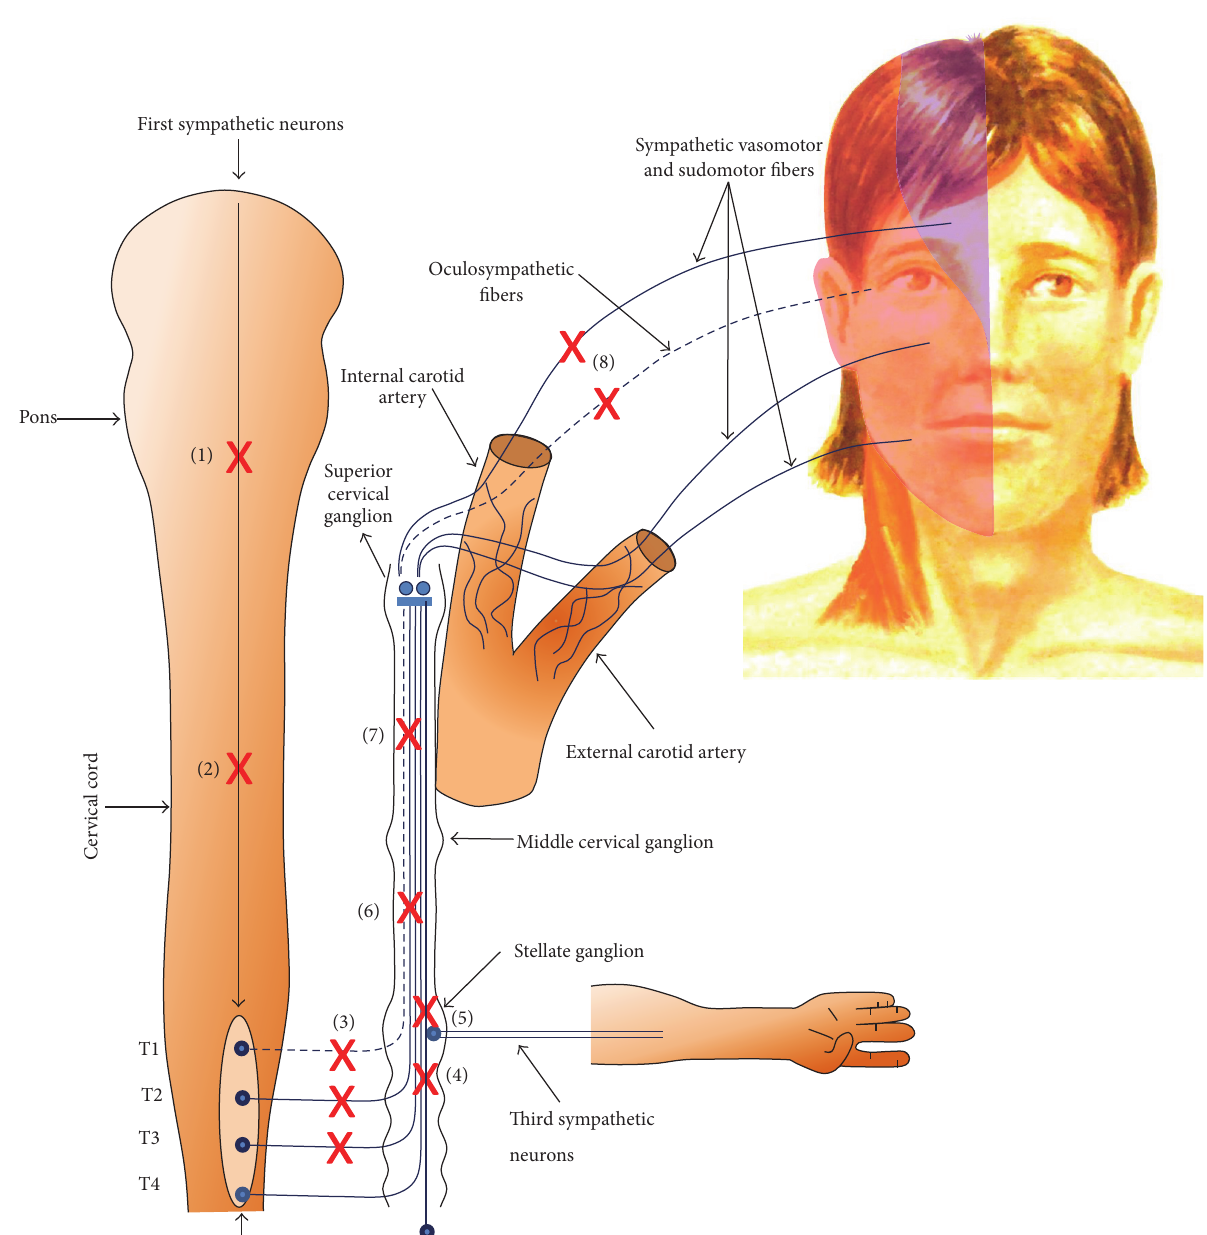
Figure 1: Diagram demonstrating the sympathetic innervation to the face with possible lesion sites. (1) = lesions within the pons, (2) = lesions within the spinal cord, (3) = lesions within the thoracic roots T1–T3, (4) = sympathetic chain between T1 and T2, (5) = stellate ganglion, (6) = sympathetic chain between stellate and middle cervical ganglion, (7) = sympathetic chain between middle and superior cervical ganglion, and (8) = sympathetic fibers traveling with the internal carotid